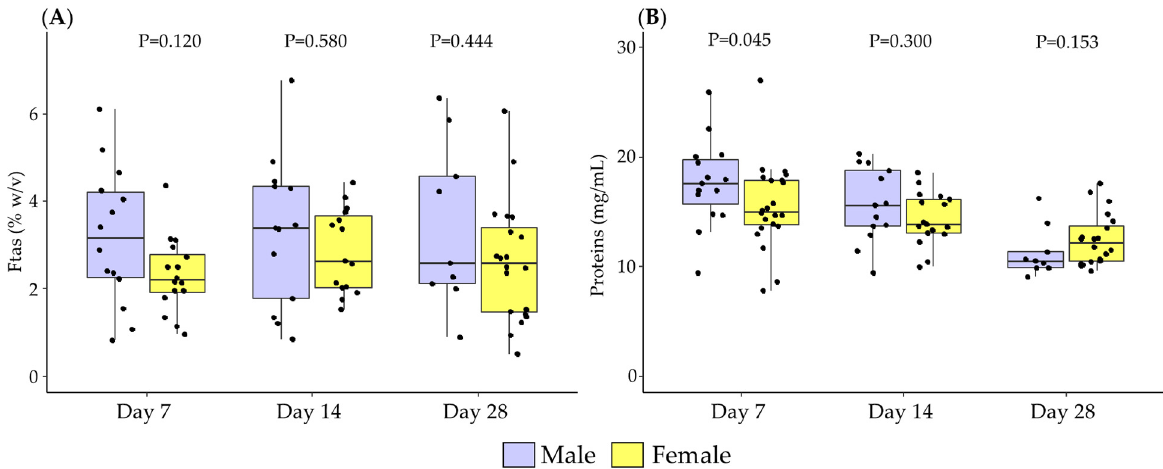
Figure 1. The evolution of breast milk fat ( A ) and proteins; ( B ) during the first month of lactation according to the sex of the newborn. Data show median and interquartile range [Q1; Q3]. Neonatal sex was compared by day using the Mann–Whitney U test and extracted p -Value ( p ) adjusted by Holm-Bonferroni multiple comparison methods was reported in the